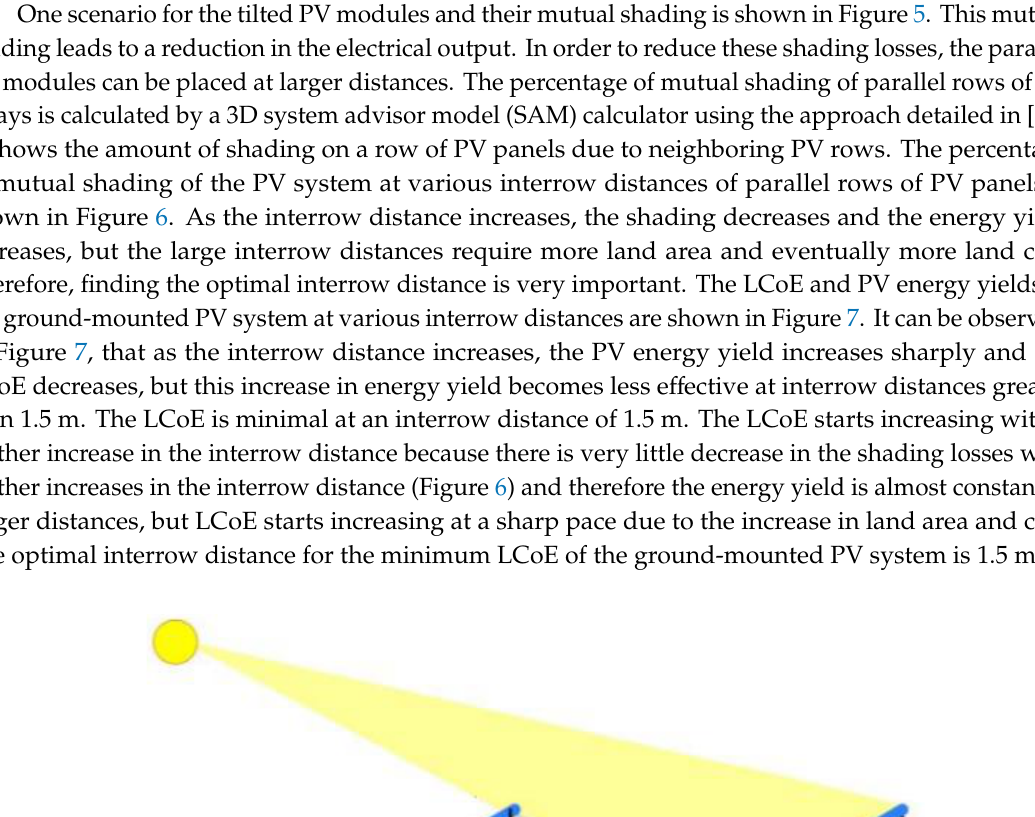
Figure 6. Diffuse shading at various interrow distances. Figure 7. Energy yield and levelized cost of energy (LCoE) of the ground-mounted PV configuration. 5.1.2. Rooftop PV System As discussed in Section 5.1.1, the LCoE decreases and the energy yield increases with the increase in the interrow distance. In the case of the rooftop PV system, which has an added advantage of rooftop shading, this increased distance exposes a larger roof area to sun rays and increases the cooling load requirement (Table 5). For the rooftop PV system, the saving in the cooling energy load is also included in the calculations of energy yield and LCoE. Figure 8 shows the energy yield and LCoE for various interrow distances from 0.5 m to 4 m for three cases, i.e., (1)